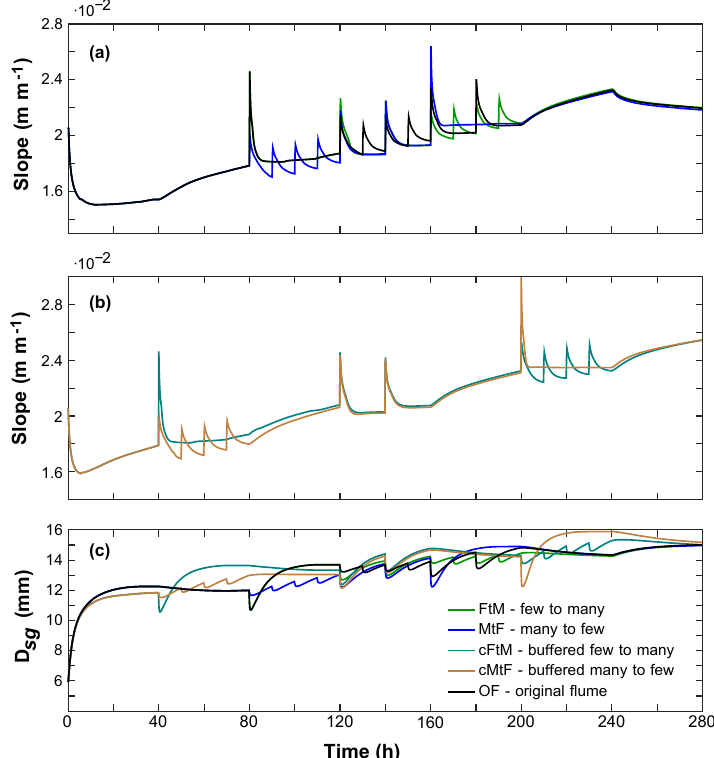
Figure 4. Comparison of slope and mean surface grain size D sg from runs with different event sequencing (see Table 2) ( σ = 1 . 6, factor of 2 increase of τ ∗ rm ). Event sequences are (a) rearranged pulse phases to the flume experiments and (b) a setup where the pulsed phases are buffered with constant-feed phases. Panel (c) shows D sg for the runs in both (a) and (b)